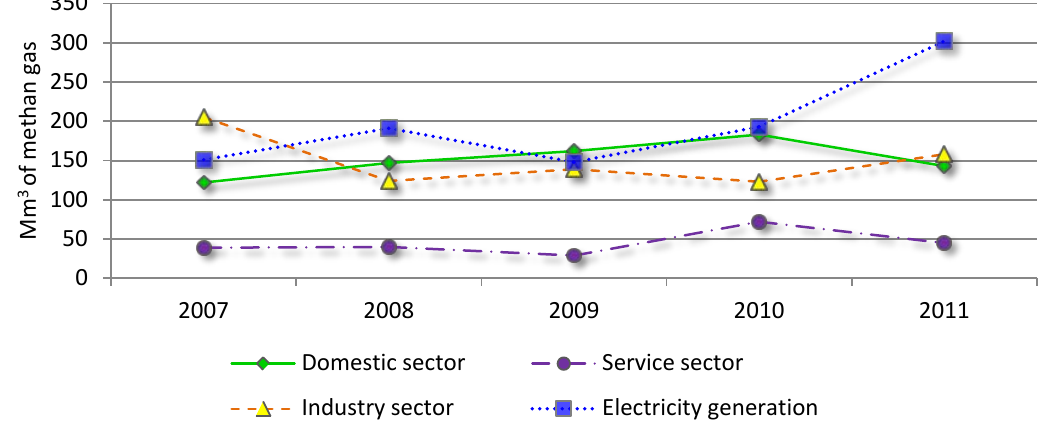
Figure 1. Methane gas consumption by sector in Basilicata. Source: Authority for Electricity and Gas (AEEG), statistical data of natural gas consumption for Italian regions, various years (2011 provisional